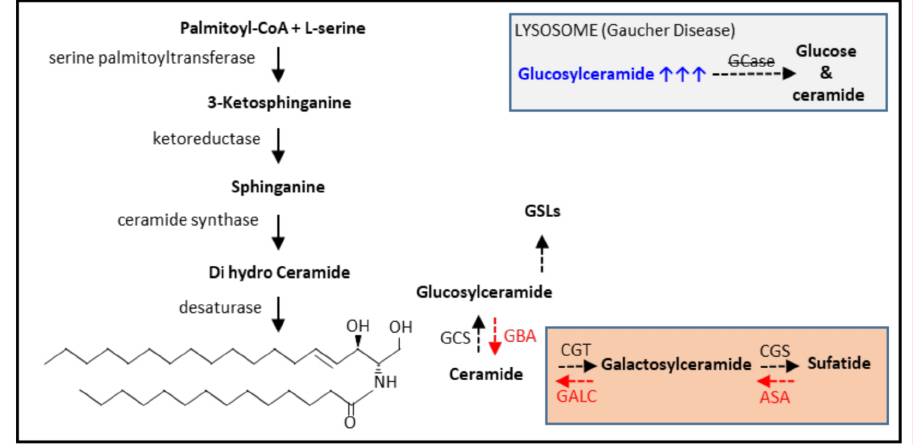
Figure 3. Brief representation of de novo ceramide synthesis and glycosphingolipid metabolism. GCS (glucosylceramide synthase), CGT (ceramide galactosyltransferase), CGS (cerebroside sulfotrans- ferase). GBA ( β -glucocerebrosidase/GCase), ASA (Arylsulfatase A), GALC ( β -galactosylceramidase), GSLs (glycosphingolipids). In the grey box, Gaucher disease and glucosylceramide accumulation are depicted. In the orange box, the GSL species present in myelin are depicted. Black dashed arrows, GSL synthesis. Red dashed arrows, GSL